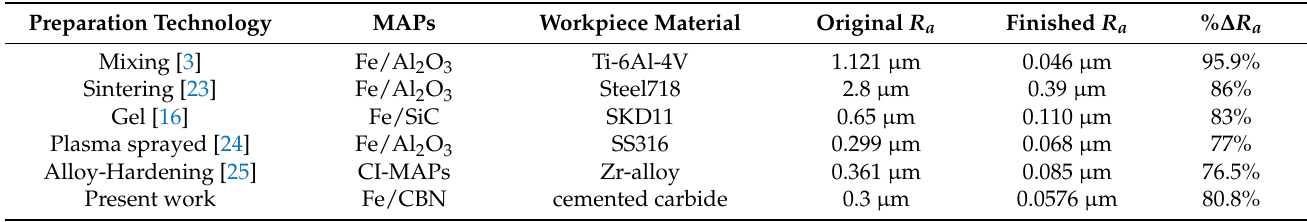
Table 8. Performance survey of MAPs.